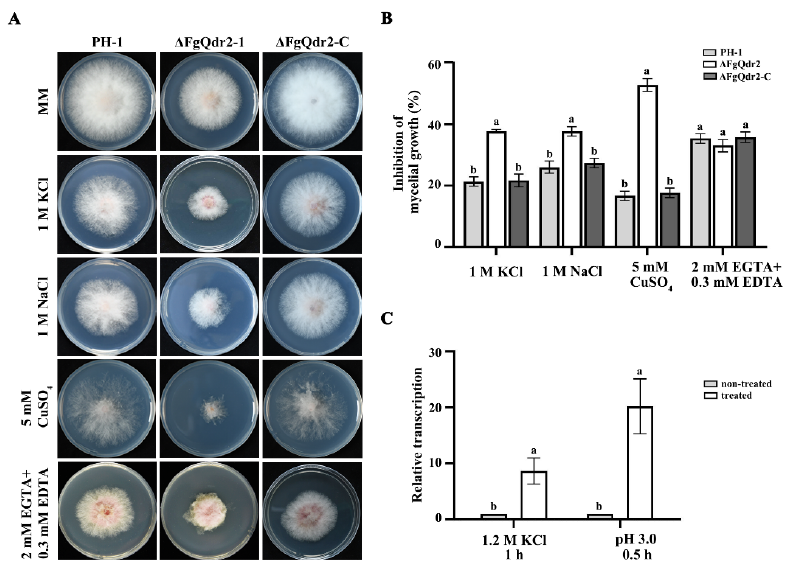
Figure 3. FgQdr2 is involved in the transport of potassium, sodium, and copper, as well as the regulation of membrane proton gradient. ( A ) Sensitivity of each strain to the corresponding stress agents. ΔFgQdr2 exhibited increased sensitivity to K + Na + , Cu 2+ osmotic stresses, and displayed similar sensitivity to the divalent cation chelator ethylene diamine tetra-acetic acid (EDTA), com- pared with the wild type. Each strain was cultured on MM, with or without the corresponding stress agents. The images were taken after 3 d incubation at 25 °C, and the mycelial growth inhibi- tion was calculated for each strain. ( B ) The mycelial growth inhibition of each strain under the above drug treatments. ( C ) The qRT-PCR revealed that the transcription level of FgQDR2 was in- creased under K + and H + inductions. The stain was first cultured in yeast extract peptone dextrose (YEPD) for 24 h, then transferred to YEPD supplied with (treated) or without (non-treated) the corresponding ion stress agents. The expression level of FgQDR2 in the non-treated strain was re- ferred to as 1, and the FgACTIN gene was used as the internal control for normalization. For ( B ) and ( C ), mean and standard deviation were estimated with data from three independent biological replicates (n = 3). Different letters indicate significant differences based on ANOVA analysis, fol- lowed by Turkey’s multiple comparisons test ( p < 0.05). 3.6. FgQdr2 is Required for the Virulence of F. graminearum Considering the significant roles of FgQdr2 in facilitating ions and solutes moving through the membranes, we speculated that FgQdr2, besides regulating growth, may be crucial for the infection of F. graminearum . As expected, scab symptoms caused by ΔFgQdr2 were restricted to the inoculated spikelet and the adjacent two or three spikelets fifteen days after inoculation (Figure 4A), whereas the wild type and the complemented strains caused typical scab symptoms on wheat heads under the same condition (Figure 4A). Additionally, the examination of virulence on wheat coleoptiles showed that ΔFg Qdr2 infected coleoptiles displayed shorter brown necrotic lesions than those of PH-1 and ΔFg Qdr2-C infected coleoptiles (Figure 4B), indicating the reduced virulence of ΔFg Qdr2 on wheat coleoptiles. Accordingly, virulence assay on corn silks showed that ΔFg Qdr2 also demonstrated attenuated virulence on corn silks (Figure 4C), suggesting